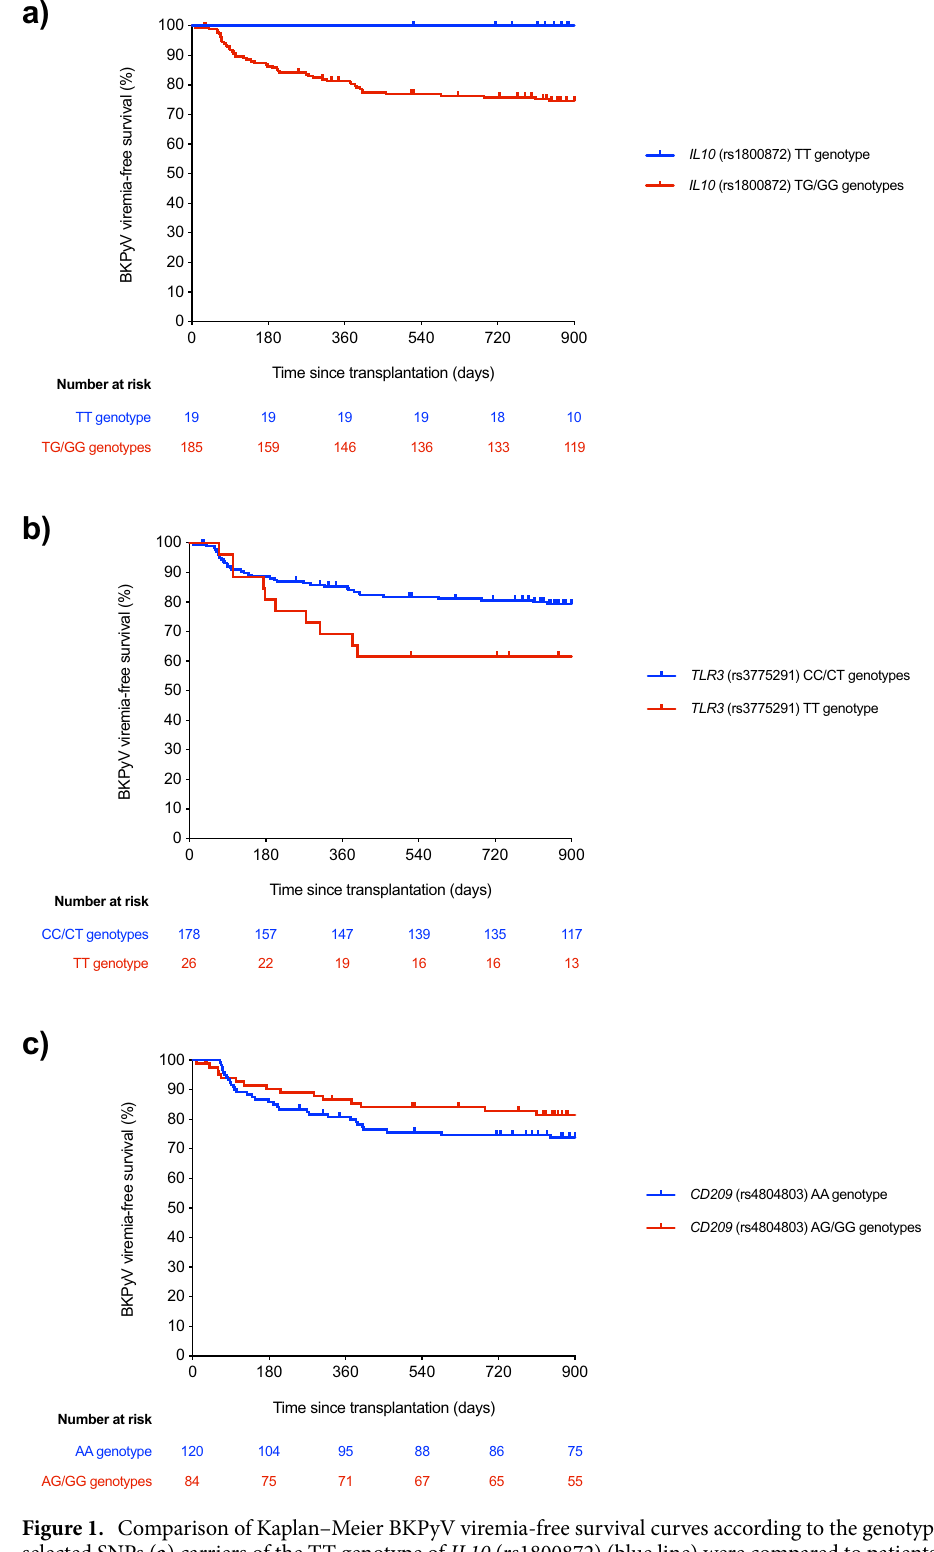
Figure 1. Comparison of Kaplan–Meier BKPyV viremia-free survival curves according to the genotype of selected SNPs ( a ) carriers of the TT genotype of IL10 (rs1800872) (blue line) were compared to patients with TG/GG genotypes (red line) (log-rank P value = 0.015); ( b ) carriers of CC/CT genotypes of TLR3 (rs3775291) (blue line) were compared to TT genotype carriers (red line) (log-rank P value = 0.026); and ( c ) carriers of the AA genotype of CD209 (rs4804803) (blue line) were compared to those with AG/GG genotypes (red line) (log- rank P value = 0.096). BKPyV: BK polyomavirus; SNP: single-nucleotide